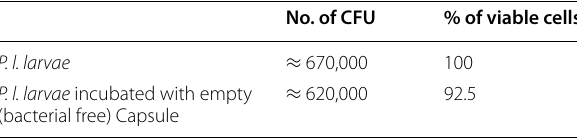
Table 6 Effect of whole capsule on P. l. larvae